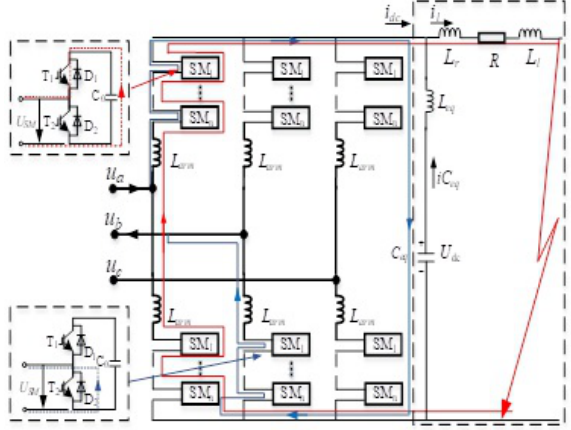
Fig. 6. Equivalent circuit of the pole-to-pole